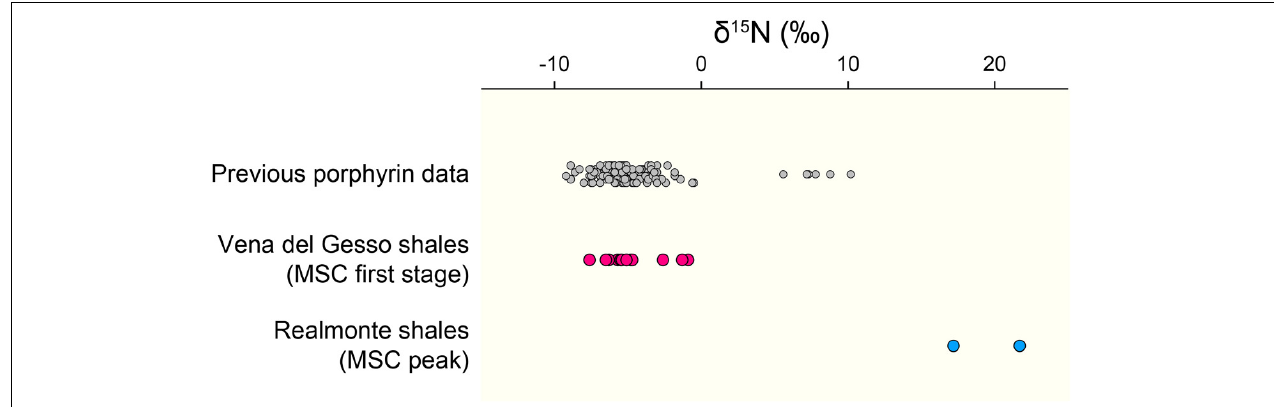
FIGURE 4 | The δ 15 N values of geoporphyrins compiled from previous studies (gray circles: Chicarelli et al., 1993; Ohkouchi et al., 2006; Kashiyama et al., 2008a,b, 2010; Higgins et al., 2012; Junium et al., 2015; Gueneli et al., 2018), those determined for the PLG shales in this study (pink circles), and those of the shale layers in the Realmonte salt mine in Sicily deposited during the MSC peak (blue circles: Isaji et al., 2019).